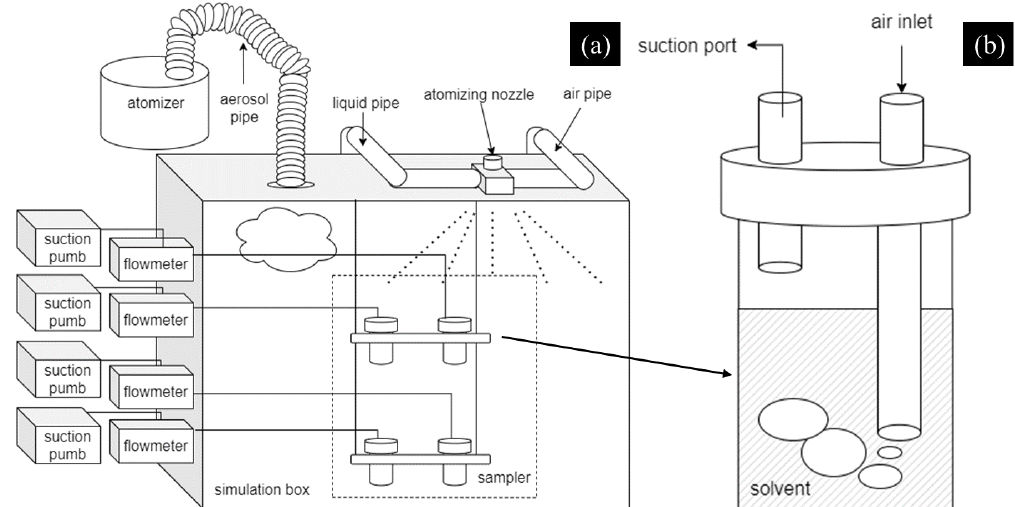
Figure 13. Schematic diagrams of the experimental system: ( a ) simulated aerosol sedimentation system; ( b ) sampler device.